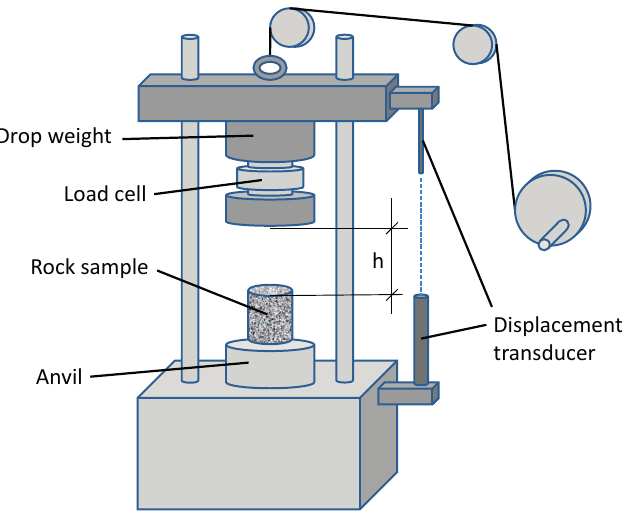
Figure 7. Micro-stamping device.